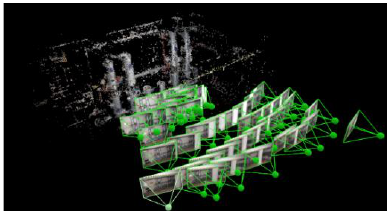
Figure 9: The generated sparse point cloud using SfM To exclude the possible outliers and having a robust estimation of the transformation parameters, the 3D residuals of the corresponding keypoints are computed after transformation with respect to their corresponding TLS coordinates. The outliers are eliminated by performing 2 𝜎 test in five iterations. The L2-norms of the residuals are computed for each correct corresponding point and illustrated in Fig. 10. As shown in this figure, the L2- norms of the residuals are mostly close to zero and only a few of them are around 2 mm, which means the fine registration might be neglected.